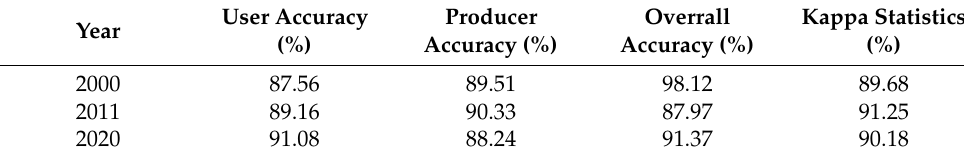
Figure 3. LULC classification of the study area using the SVM algorithm. Table 2. Accuracy assessment of classified LULC maps using SVM algorithm.